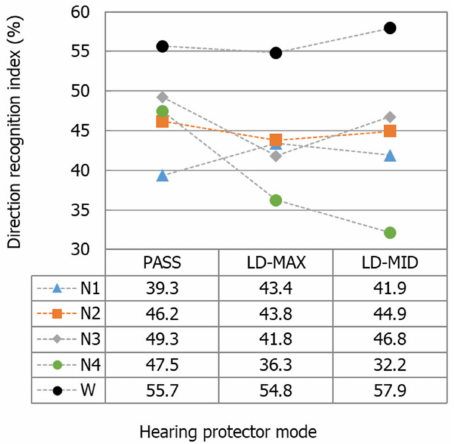
Figure 6. Values of the direction recognition index determined for all of the measurement data obtained for each of the hearing protectors with a breakdown by the operation mode of these protectors. PASS—with the level-dependent system switched off. LD-MAX—level-dependent mode, with maximum amplification in the sound transmission path; LD-MID—level-dependent mode with the amplification set to incomplete (approximately half).